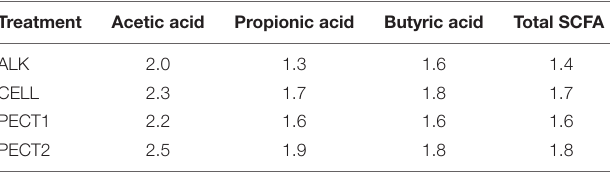
TABLE 1 | Fold change of cumulative Acetic, Propionic, and Butyric acid, and total short-chain fatty acid production during fermentation of ALK, PECT1, PECT2, and CELL compared to